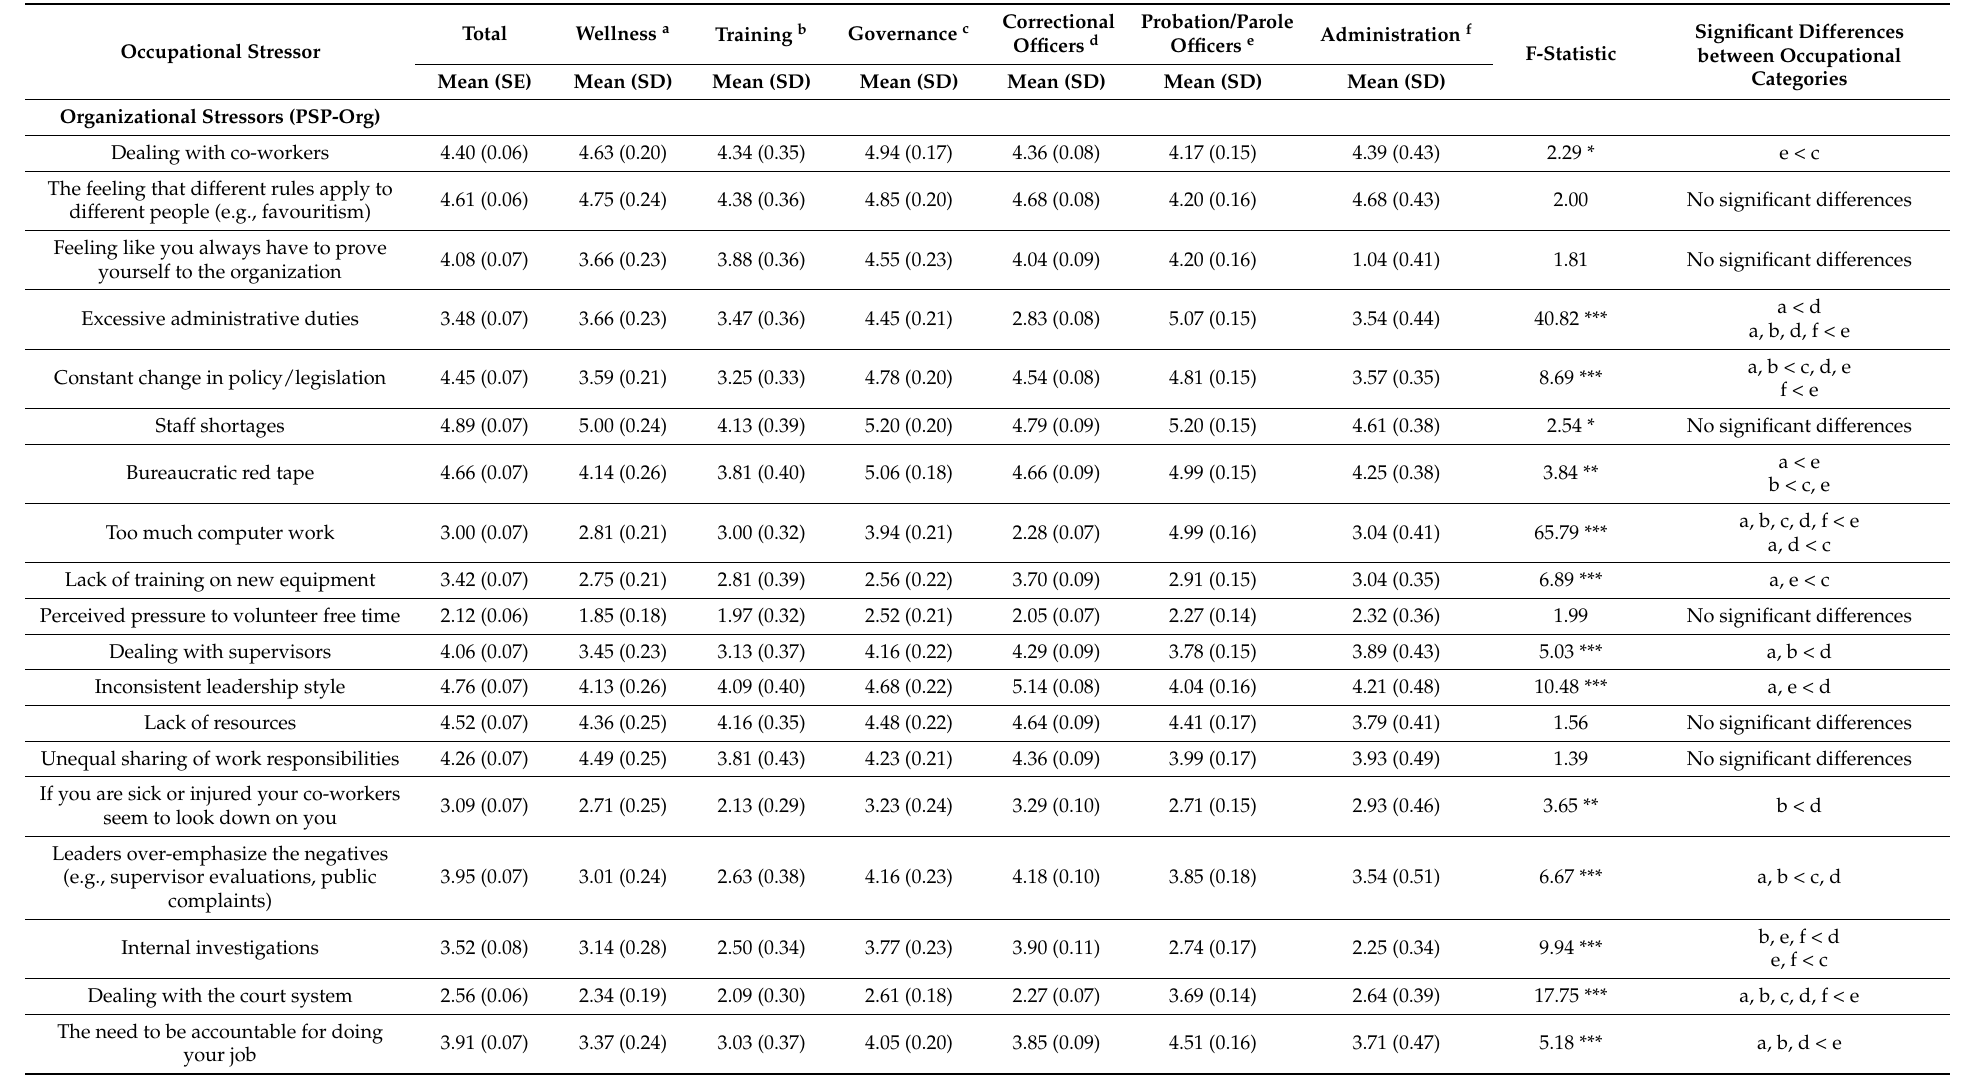
Table 2. Mean stress levels associated with occupational stressors across correction worker occupational categories in Ontario,